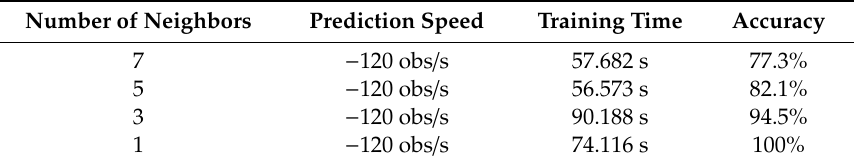
Table 2. Comparison K numbers of